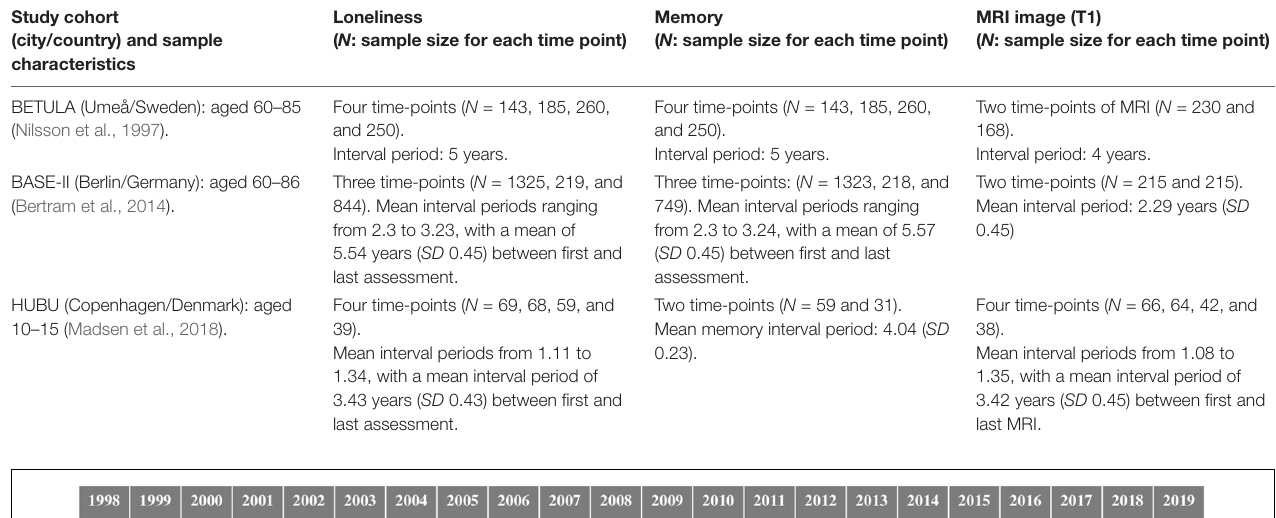
TABLE 1 | Lifebrain eligible study cohorts: sample sizes and waves of assessment for each measure of loneliness, episodic memory, and magnetic resonance imaging (MRI). Study cohort (city/country) and sample characteristics BETULA (Umeå/Sweden): aged 60–85 (Nilsson et al., 1997).